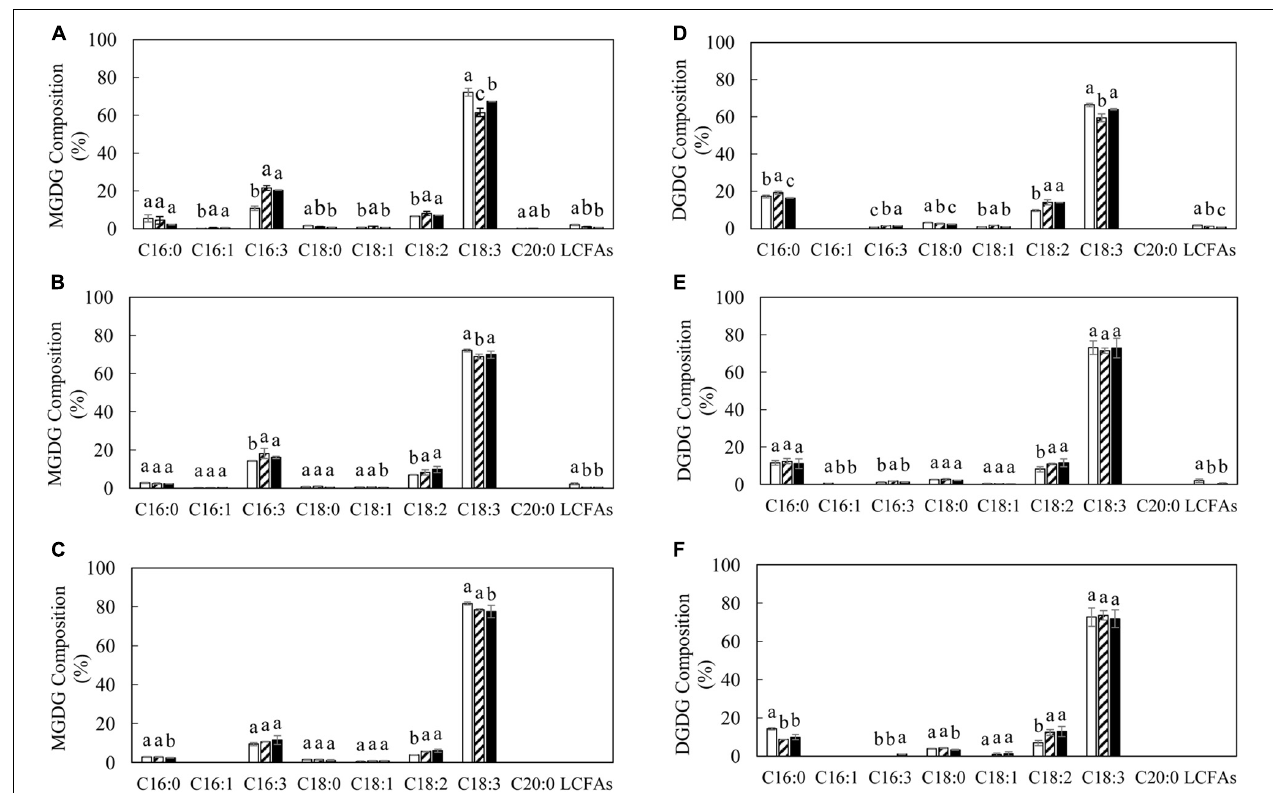
FIGURE 5 | Fatty acid compositions of MGDG and DGDG in potato leaves at the three developmental stages in WT (open bar), L3 (bar with upward diagonal) and L5 (black bar). (A–C) MGDG at the flowering, mature, senescent stages respectively; (D–F) DGDG at the flowering, mature, senescent stages respectively. The data represent the mean values ± SD of three biological replicates. Letters (a, b, c, and d) above the bars are based on LSD, bars marked with different letters are statistically significantly different at P <